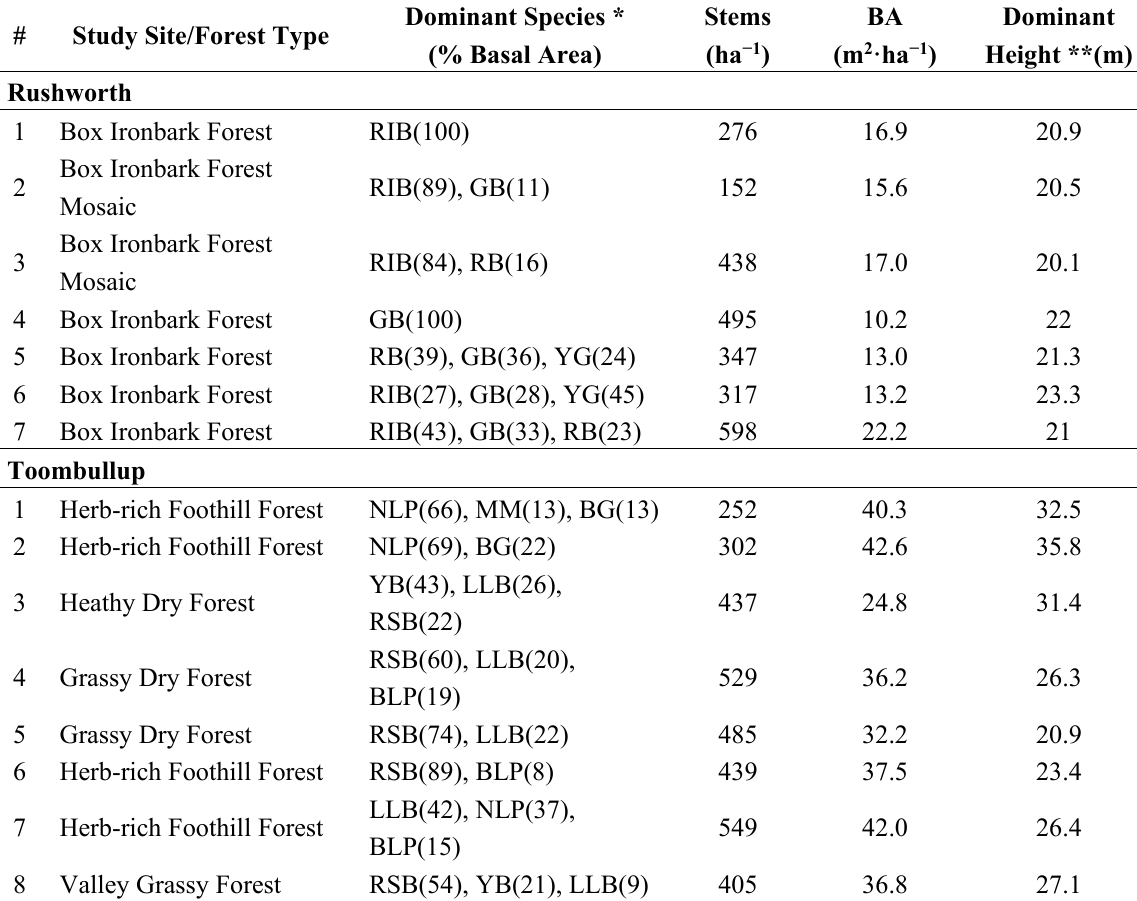
Table 1. Details of the forest at each study site including overstorey species composition and stand